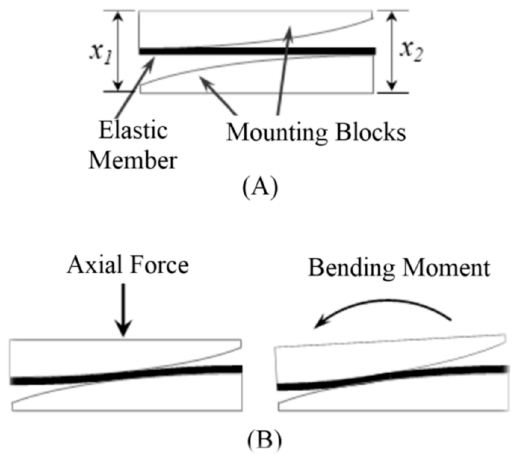
Figure 1. Functioning mechanism of the FM-PLS: ( A ) schematic of the sensor structure, and ( B ) deflections under axial force and bending moment.